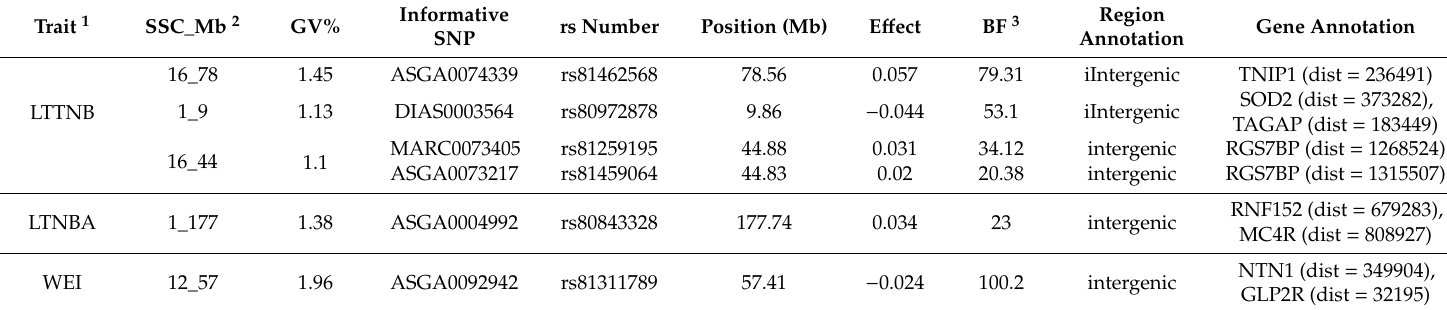
Table 3. Informative 1-Mb genome windows and single nucleotide polymorphism (SNPs) within windows associated with reproduction traits in Yorkshire pigs from the GWAS using markers on Illumina